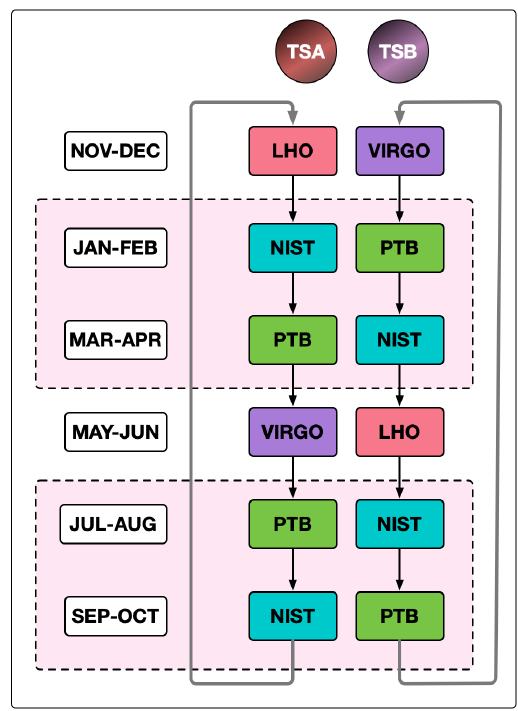
Figure 7. First year schedule during which each transfer standard (TSA and TSB) will be calibrated at NIST and PTB twice per year and arrive at each observatory (Virgo and LHO) once per